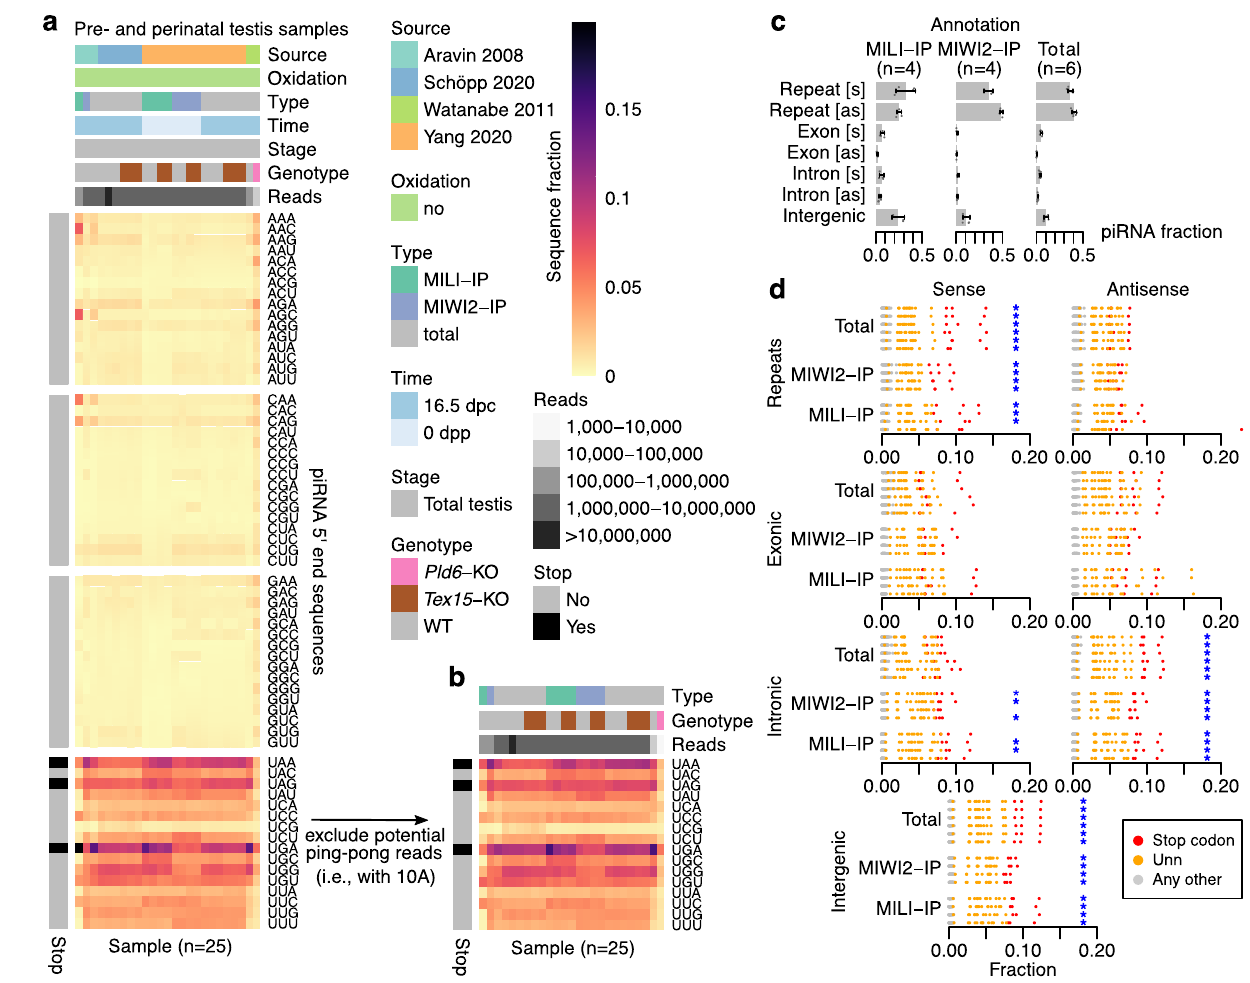
Fig. 2 Pre- and perinatal piRNAs are enriched for stop codons at their 5 ′ ends. a Heatmap showing sequence distribution at piRNA 5 ′ ends across 25 small RNA-seq libraries from pre- and perinatal mouse testis. Each column represents one library. Column-wise annotations describe data source publication (Source), whether oxidated RNAs were captured (Oxidation), library type (Type), developmental time point (Time), spermatogenesis stage (Stage), mouse genotype (Genotype), and number of reads (Reads). Row-wise annotations show whether a sequence is a stop codon